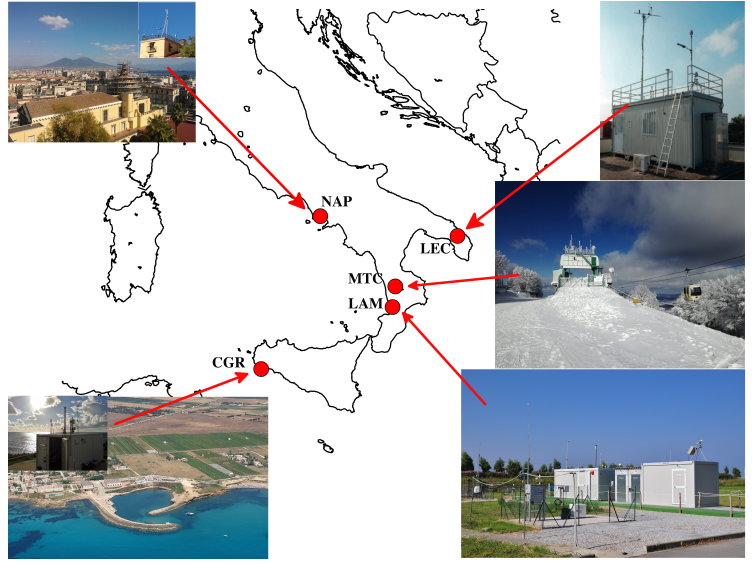
Figure 1. A map of the observation sites: NAP (Naples, urban); LEC (Lecce, urban background); LAM (Lamezia Terme, industrial); CGR (Capo Granitola, marine); MTC (Monte Curcio, remote). Table 1. The characteristics of sites and ambient PM 2.5 and PM 10